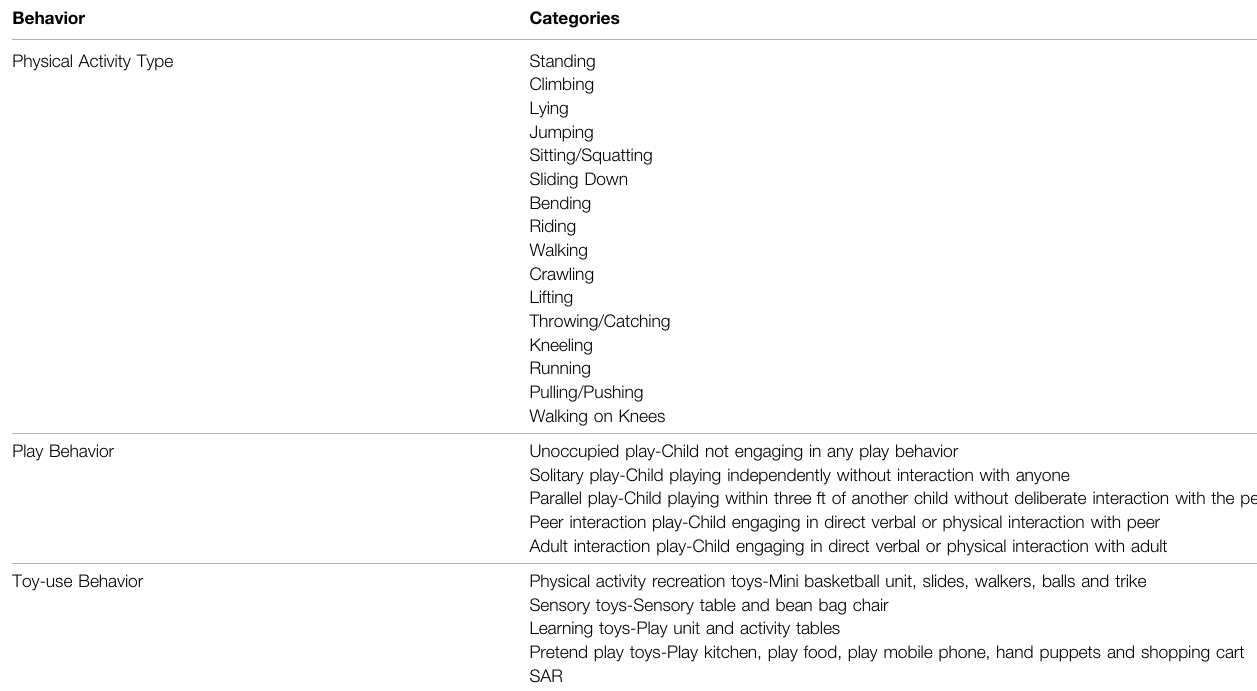
TABLE 2 | Behavior assessments with categories. Behavior